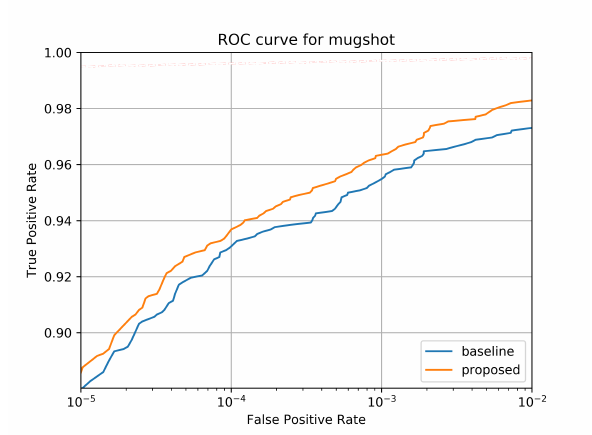
Figure 7. Face recognition on mugshot dataset Proposed method has shown slight accuracy increase (lesser